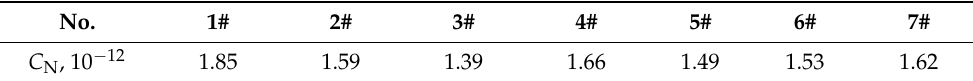
Table 3. Nitrogen capacity of